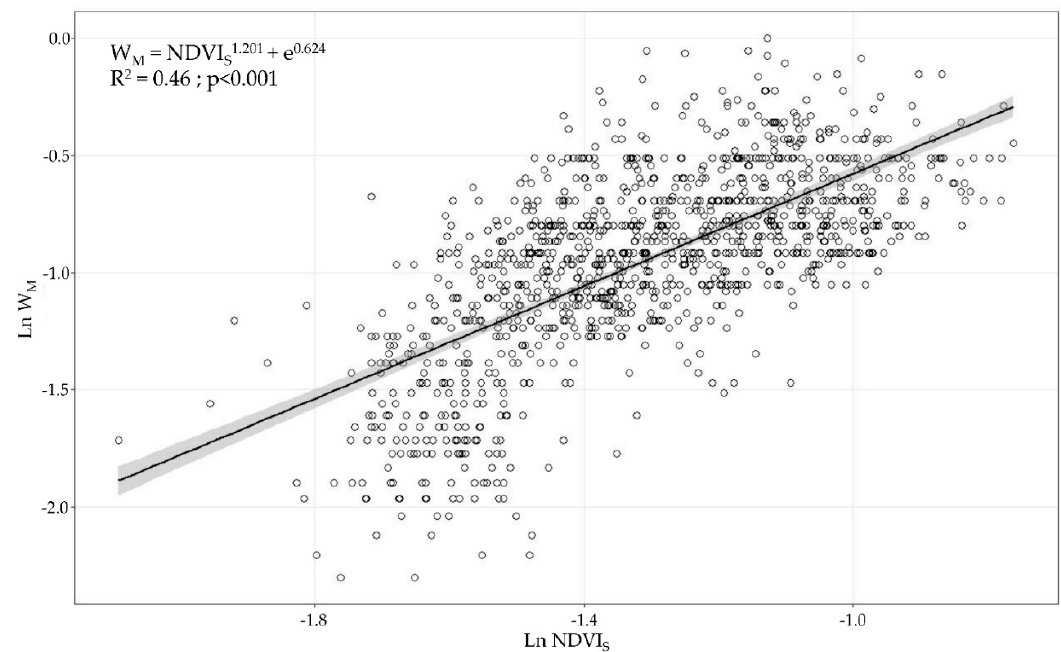
Figure 9. Linear regression model (R 2 = 0.46, p < 0.001) evaluating relationship between Ln W M and Ln NDVI S . Grey band shows 95% confidence interval.